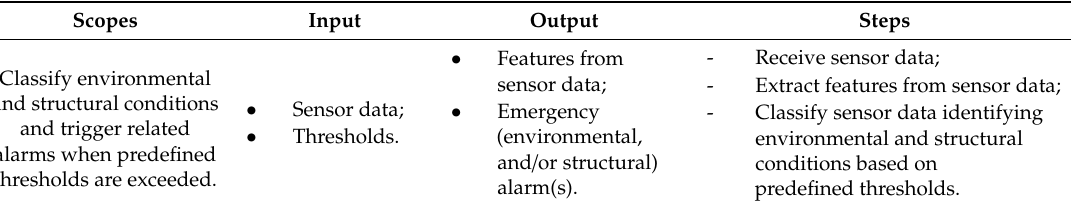
Table 4. Main characteristics of the Algorithm